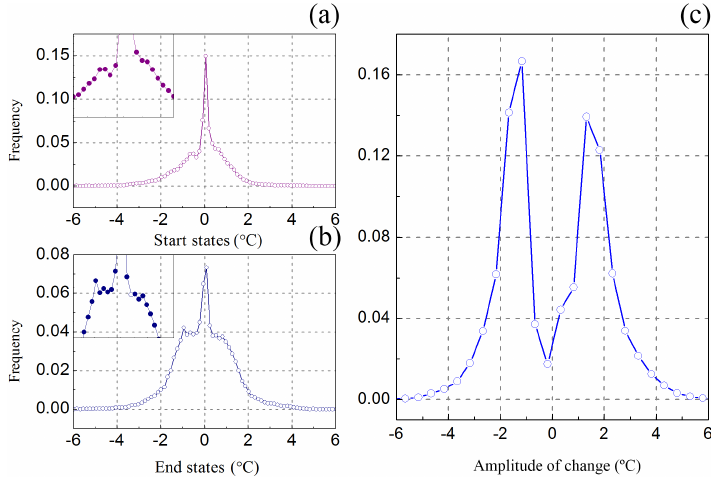
Figure 6. Bistability state characteristics study of SST system: (a) and (b) are the system state variables before and after abrupt change, respectively; and (c) is the variation quantity in the ACP of the system, namely, abrupt change